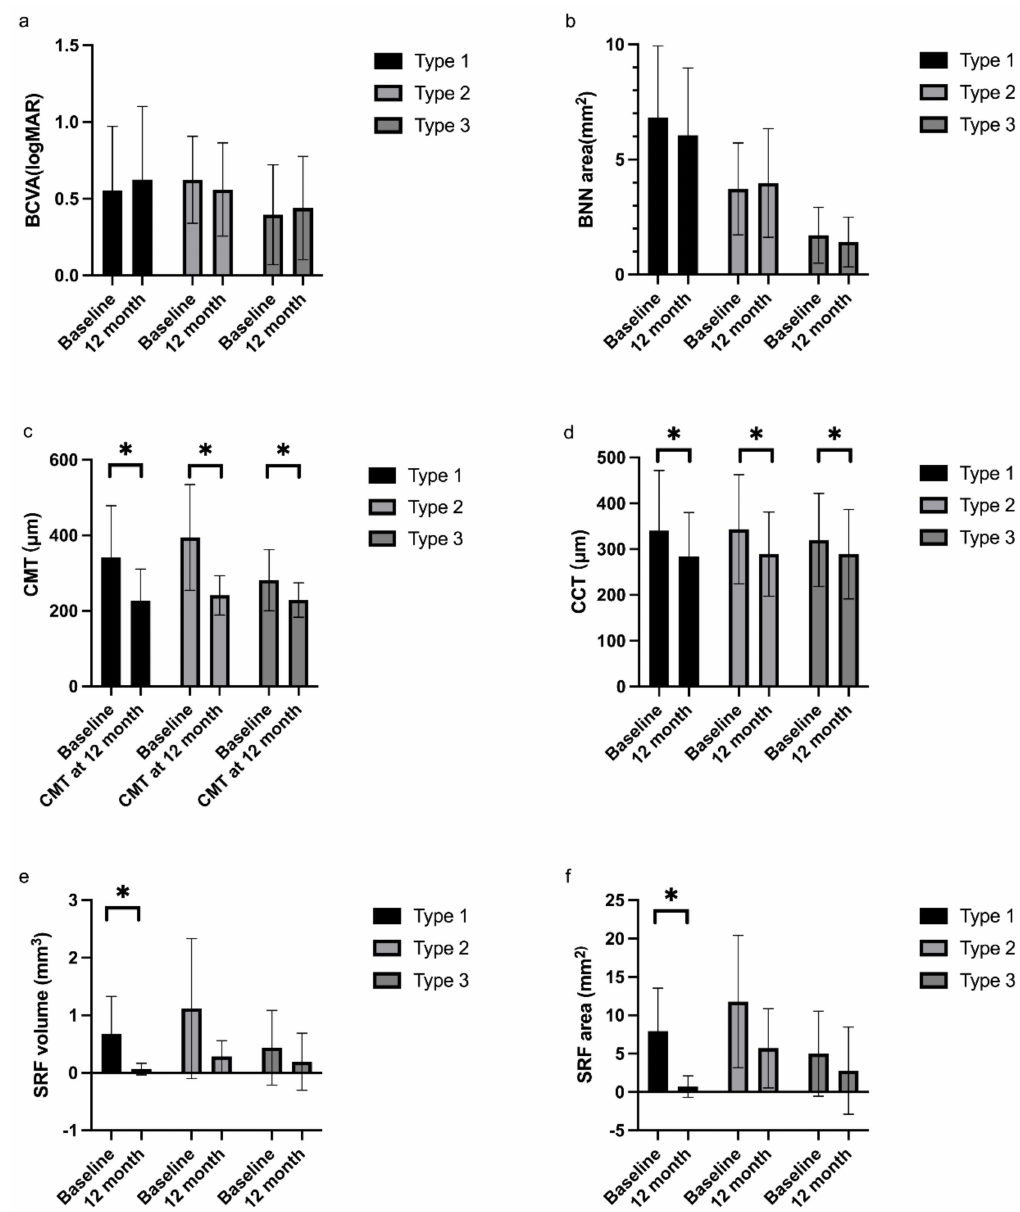
Figure 4. Comparison of BCVA and OCT/OCTA parameters in three BNN subtypes. There was no statistically significant difference in BCVA and BNN area after treatment at 12 months in each group ( a , b ). Central macular thickness decreased significantly in all three groups after anti‑VEGF treatment at 12 months ( c ). Central choroidal thickness decreased significantly in all three groups after anti‑VEGF treatment at 12 months ( d ). SRF volume decreased in all groups at 12 months but was statistically only in type 1 BNN ( e ). SRF area decreased in all groups at 12 months but was statistically only in type 1 BNN ( f ). BCVA, best corrected visual acuity; BNN, branching neovascular network; CMT, central macular thickness; CCT, central choroidal thickness; SRF; subretinal fluid. * Paired t ‑test, p <